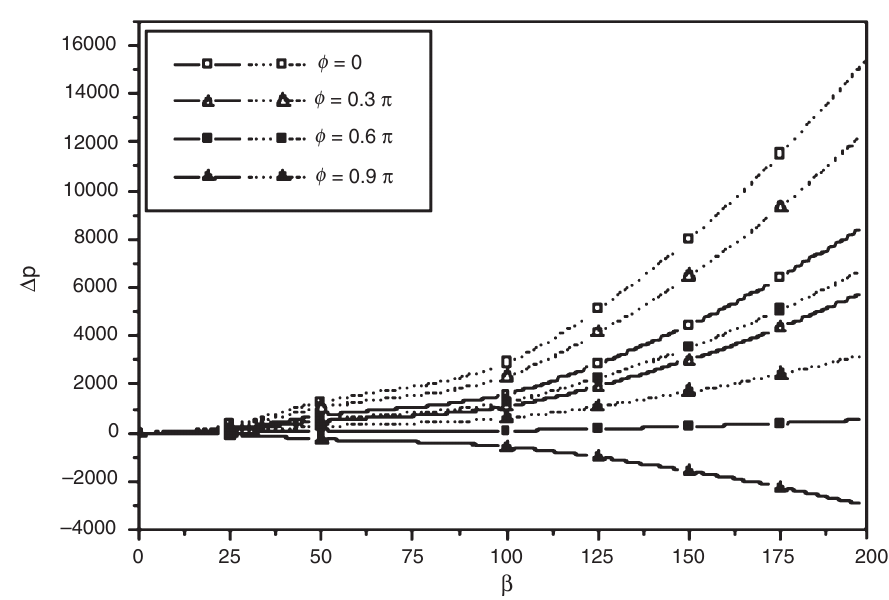
Fig. 5. variation of (cid:9) p versus β with a = b = 0 . 7, d =2 and Q = 0 . 1 (solid lines) and ( Q = − 0 . 1 dot lines) for different